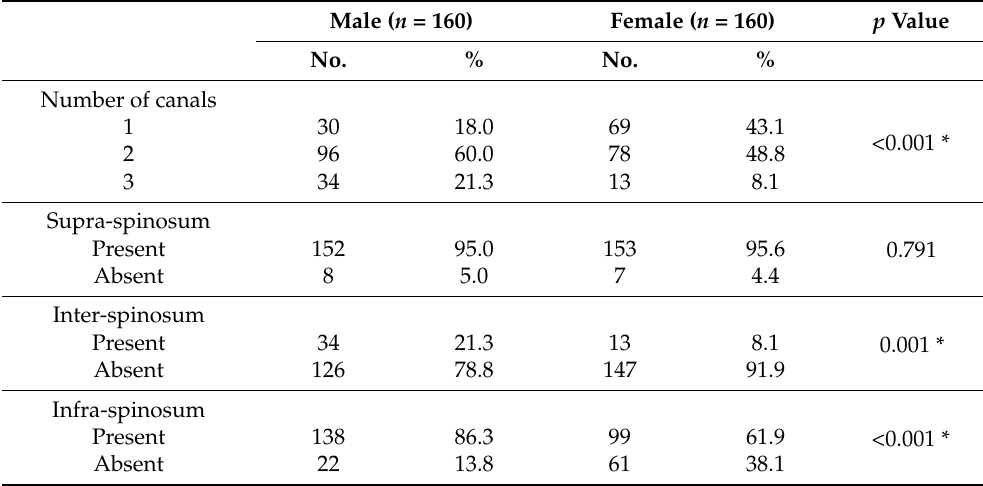
Table 3. Comparison between males and females according to the number of canals and presence of supra, inter, and infra-spinosum canals ( n = 320).